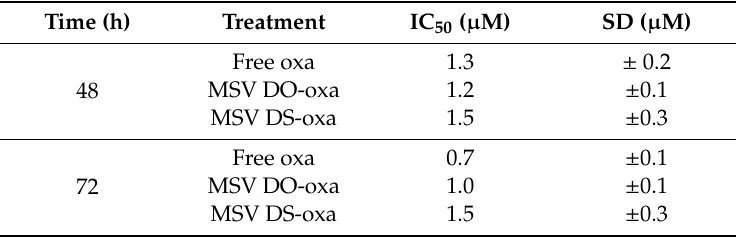
Table 3. Inhibitory Concentrations (IC 50 ) of oxa-liposome-MSV and free oxa. IC 50 values were calculated by GraphPad Prism software through interpolation with the curves of Figure 9. Statistical significance was calculated by t- test; comparisons DO-oxa vs. Free Oxa, DS-oxa vs. free oxa were significant only at 72 h ( p < 0.05). Time